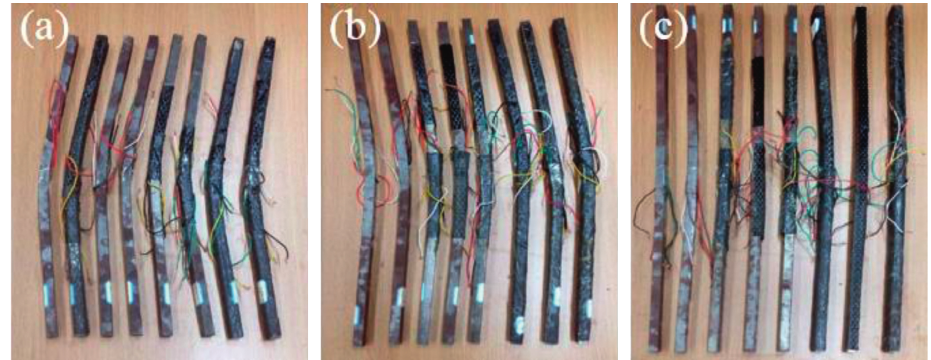
Figure 3: Buckling of steel bars with or without CRFP reinforcement. (a) Group 1; (b) Group 2; (c) Group